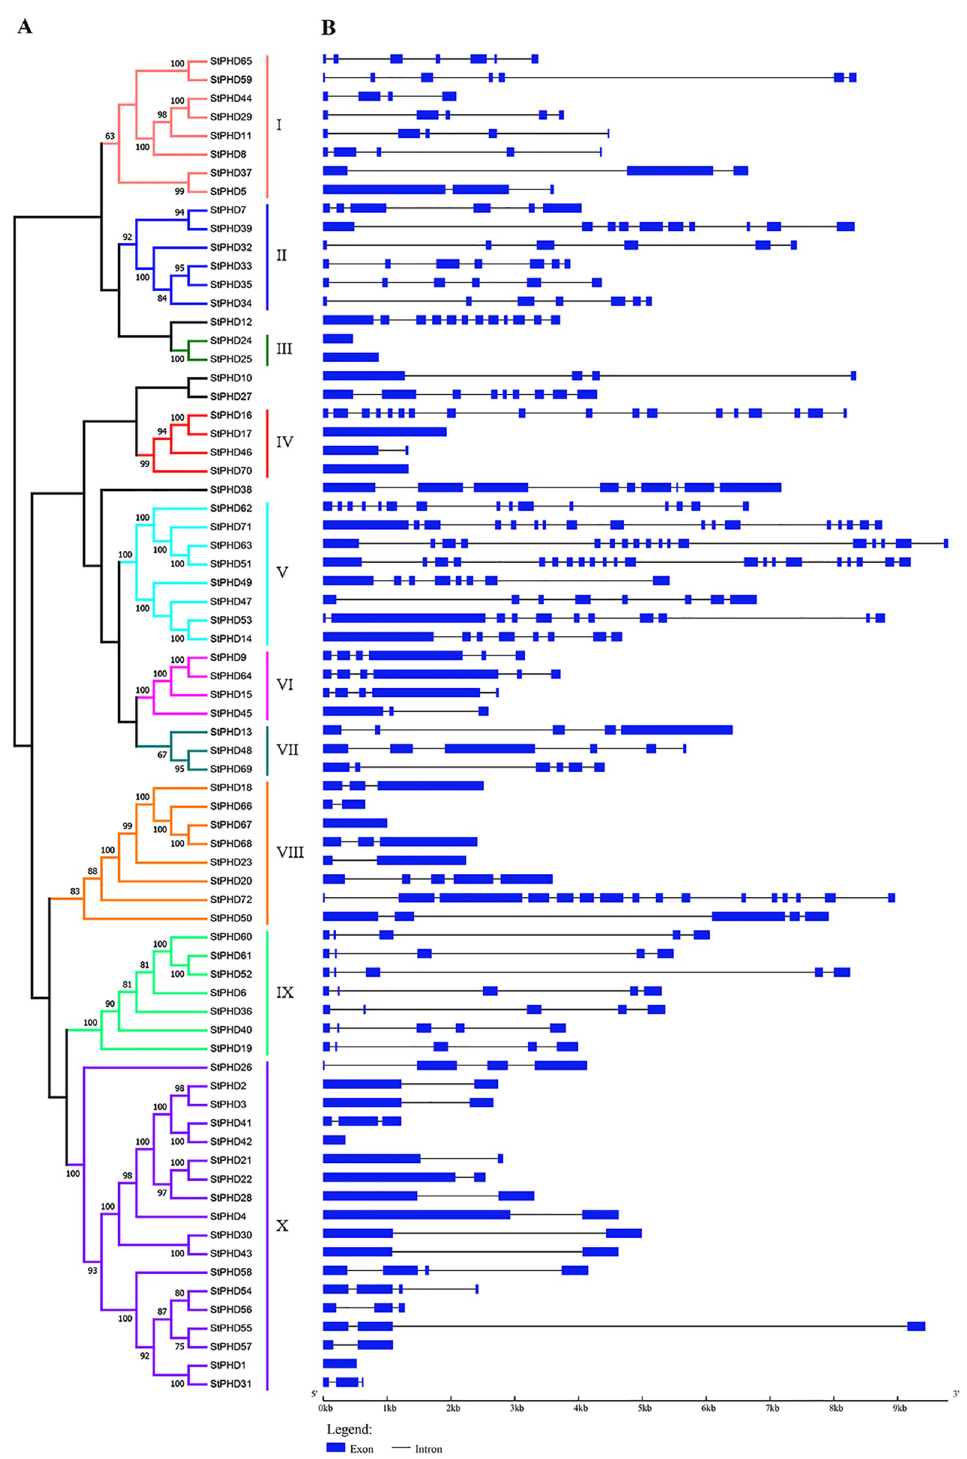
Fig 1. Phylogenetic relationships and gene structures for the StPHD family. A. Phylogenetic tree generated by maximum-likelihood method with bootstrapping analysis (1,000 replicates) based on the protein sequences of StPHD genes (percentage of bootstrap value was displayed at each node). The branches of different groups are shown in different colors. B. The graphic displays exon-intron structures for StPHD gene family members using GSDS. The horizontal black lines and the blue boxes show introns and exons, and the scale displays the relative length and position of the introns and exons.